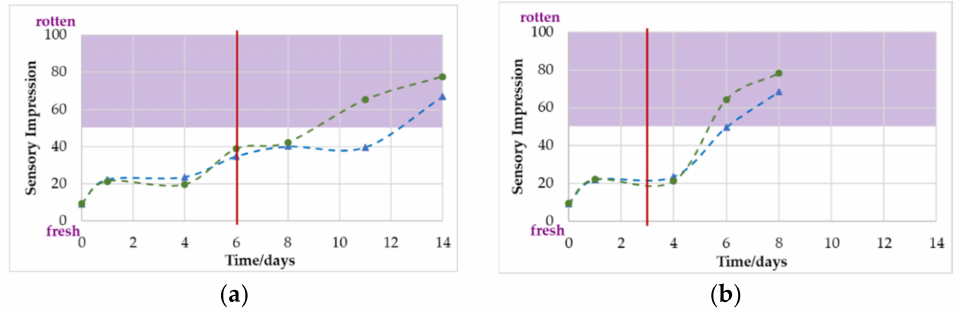
Figure 2. Visual ( (cid:78) ) and orthonasal ( • ) impressions of poultry under different storage conditions over 8 or 14 days: ( a ) 80% O 2 /20% CO 2 4 ◦ C and ( b ) 80% O 2 /20% CO 2 10 ◦ C. The red line marks the point when microbiological limit value was achieved. The purple area indicates the previous defined sensory limit of 50 scores.